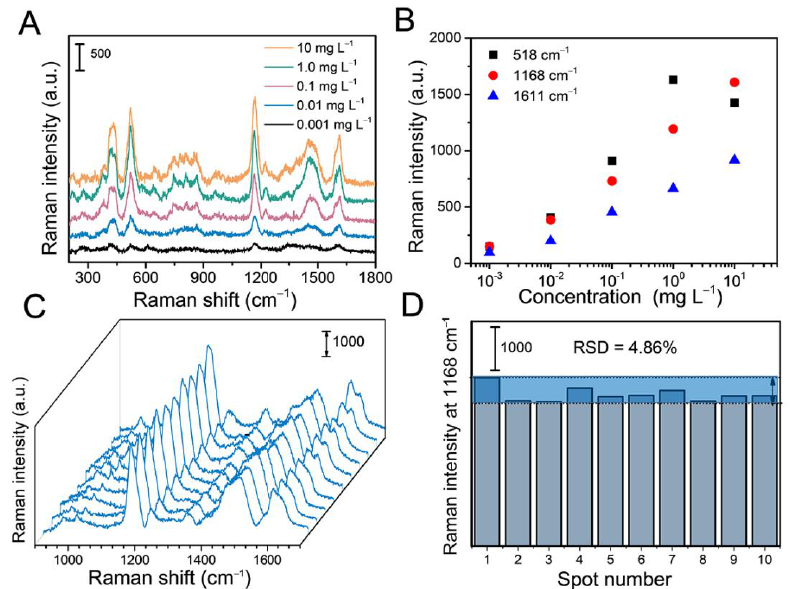
Figure 4. ( A ) SRES spectra of pAuNCs with different concentrations and ( B ) the corresponding signal intensity at 518, 1168, and 1661 cm −1 . ( C ) SERS spectra of pAuNCs collected from 10 random spots and ( D ) the corresponding signal intensity at 1168 cm −1 .